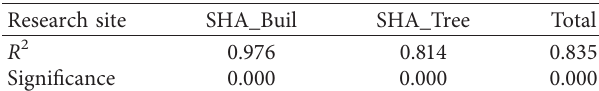
mrt under temporal variation in T a at the building and tree shaded areas: (a) SHA_Buil; (b) Table 2: Linear fitting analysis between estimated marginal mean LT mrt and T a at the building and tree shading areas and the total. Research site